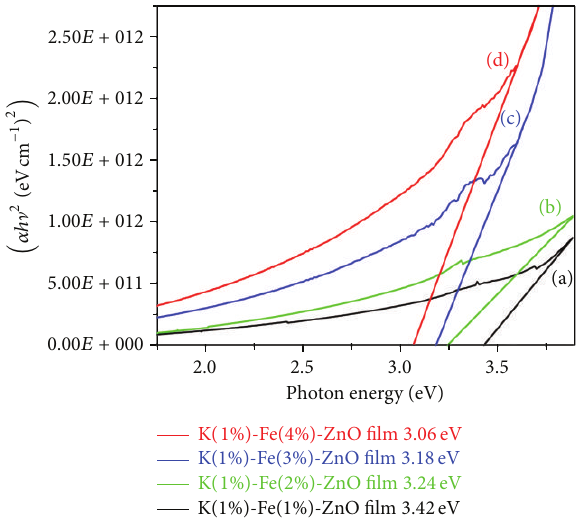
Figure 6: Optical band gap of (K (1%), Fe) codoped ZnO for Fe concentrations: (a) 1%, (b) 2%, (c) 3%, and (d)